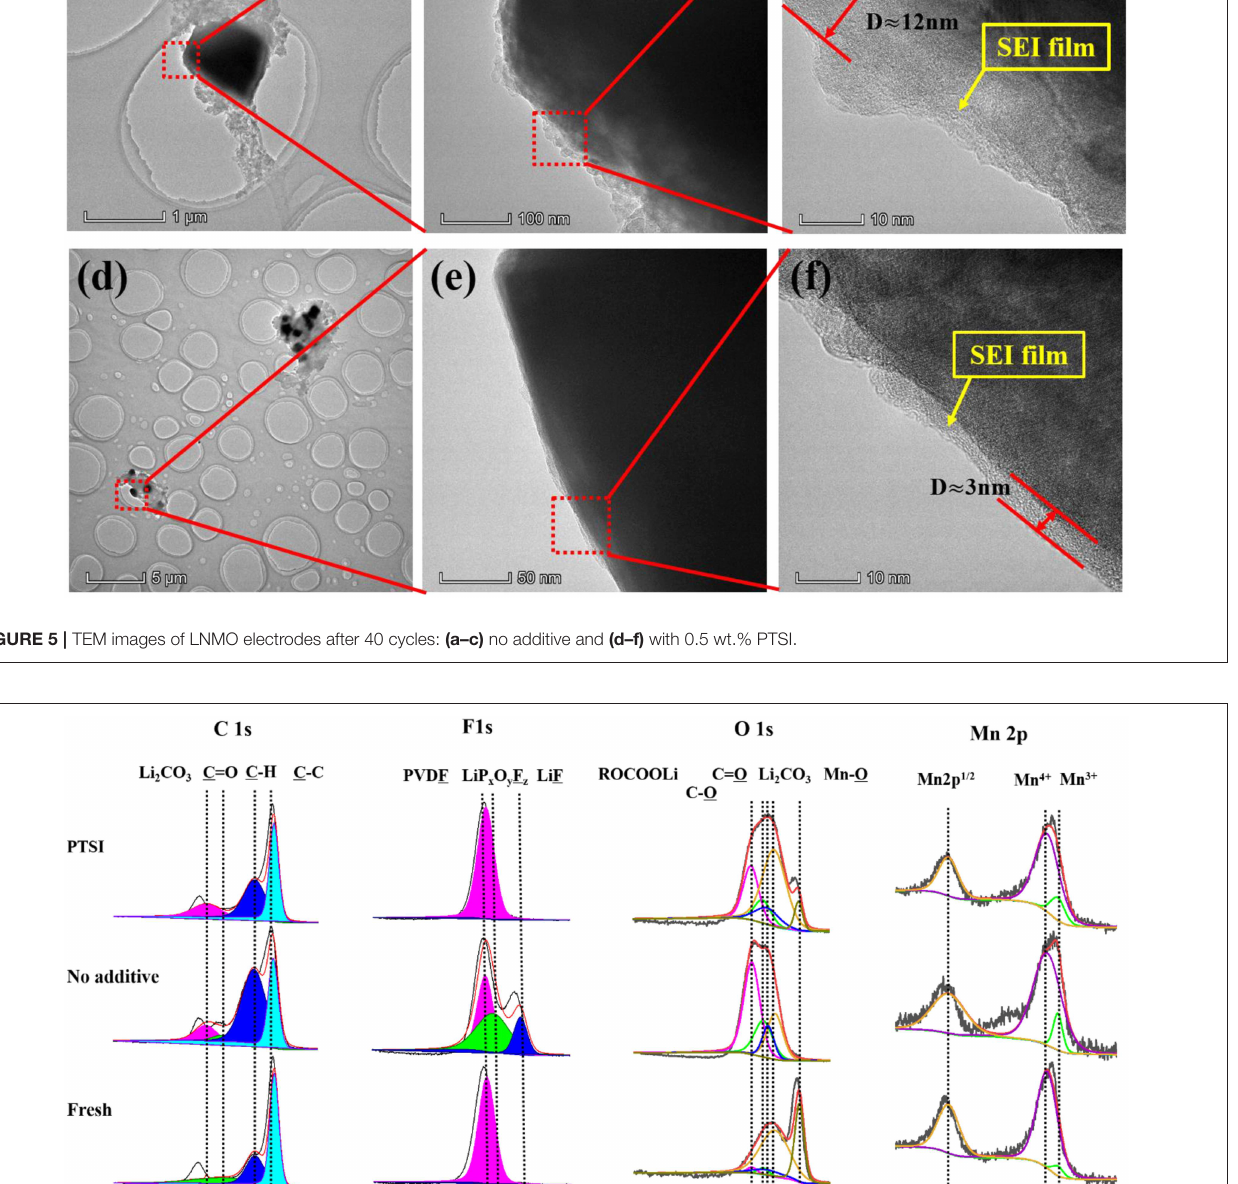
peak strength of LiF (684.5 eV) and PVDF (687.7 eV) with 0.5 wt.% PTSI was significantly lower than that with no additive (Park et al., 2010; Zhou et al., 2011), indicating that there are few inorganic products on the electrode surface. When LiF content in the SEI film increasing, it will cause